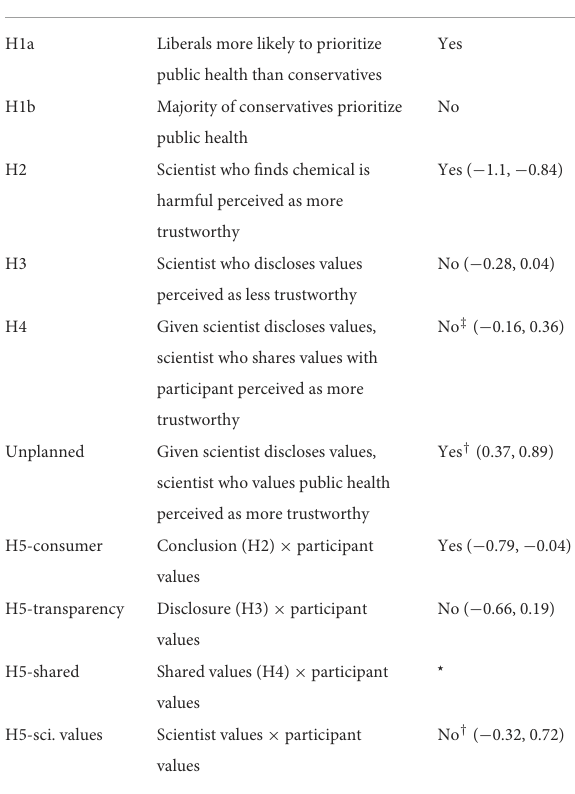
TABLE 7 Summary of replication